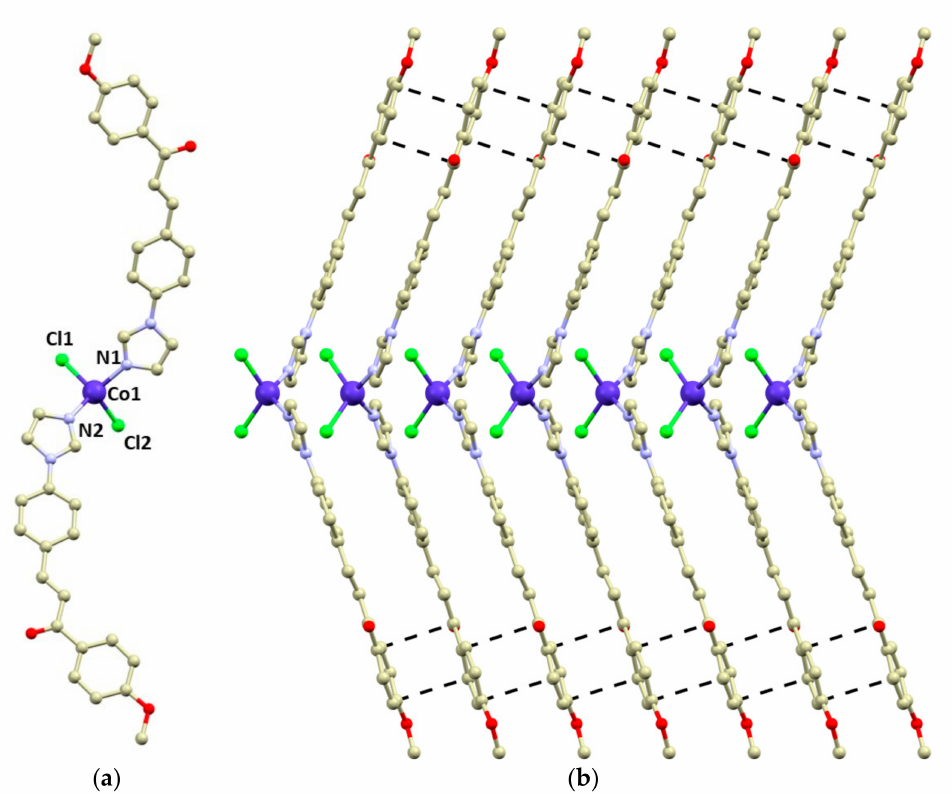
Figure 1. ( a )—molecular structure of 1 . Selected bond lengths (Å) and angles (deg): d (Co1-N1) = 2.014(4), d (Co1-N2) = 2.016(4), d (Co1-Cl1) = 2.255(2), d (Co1-Cl2) = 2.257(2), < (N1-Co1-N2) = 125.7(2), and < (Cl1-Co1-Cl2) = 119.44(6). ( b )—a perspective view of the packing of the [Co(4MeO-L) 2 Cl 2 ] molecules in the direction of the crystallographic b -axis. Observed π – π stacking interactions were visualized by depicting the shortest C ··· C distances (black dashed lines). The hydrogen atoms are omitted for